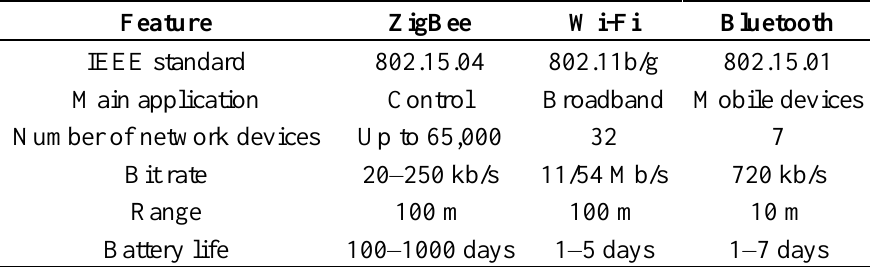
Table 2. ZigBee vs. some other wireless